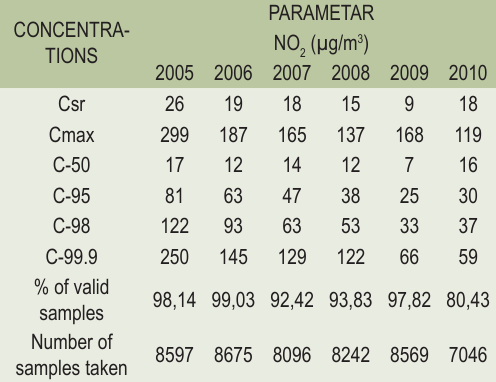
TABLE 4. Statistical overview of NO (hourly samples) Sarajevo-automatic station Bjelave